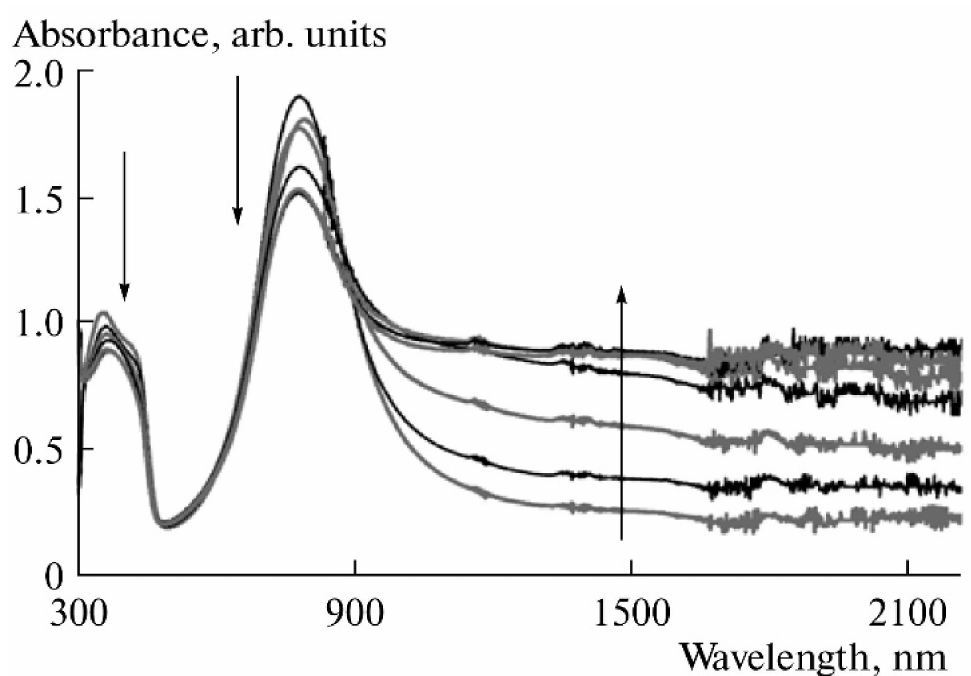
Figure 2. Evolution of the spectrum (at 0.6 V) of the film of the chemically synthesized PANI–PAMPSA interpolymer complex during CV cycling in the range of potentials of the first redox stage in an acetonitrile solution of 0.1 M HClO 4 and 0.9 M NaClO 4 . The number of cycles increases in the direction of the arrows: 0, 3, 6, 9, 12, 15, 18. Reprinted by permission from Springer Nature Customer Service Centre GmbH: Springer Nature, Russian Journal of Electrochemistry, “The spectroelectrochemical behavior of films of polyaniline interpolymer complexes in the near infrared spectral region”, A. A. Nekrasov et al., Copyright 2012